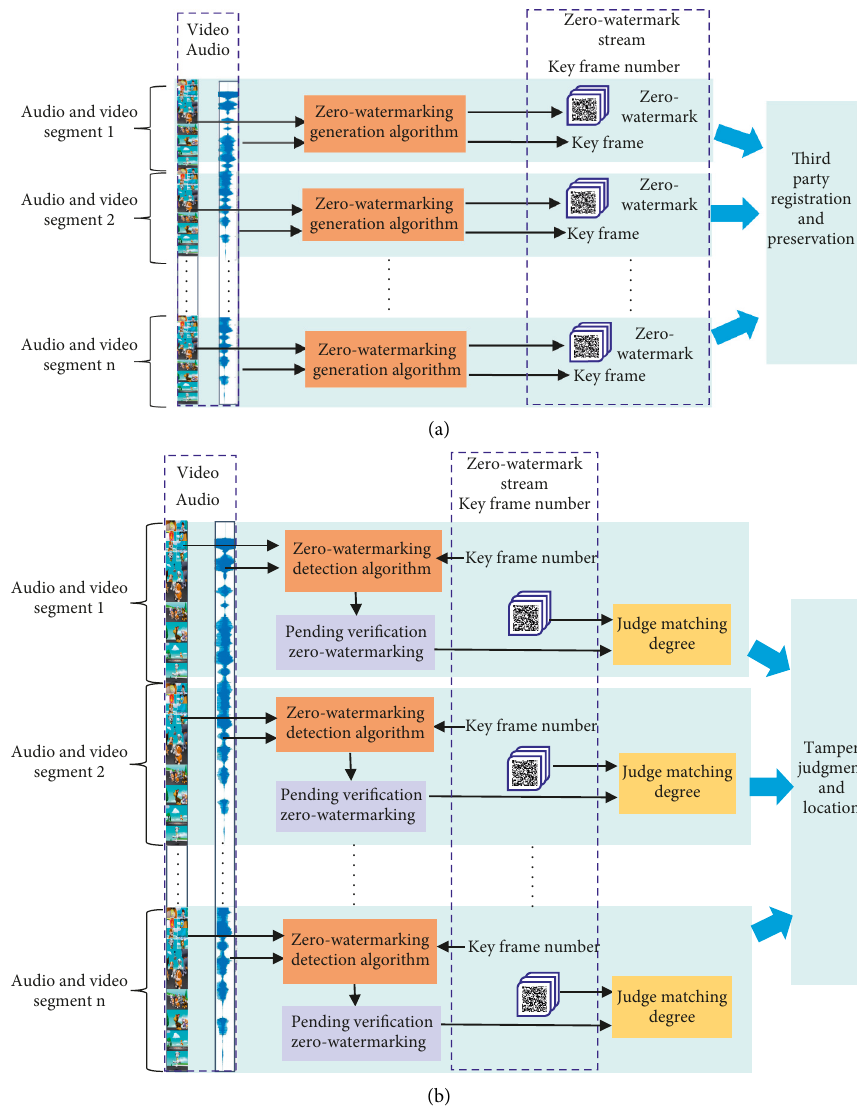
Figure 1: Total frame of zero-watermarking generation and detection based on the audio and video. (a) The overall framework of zero- watermarking generation algorithm for audio and video segments. (b) The overall framework of zero-watermarking detection